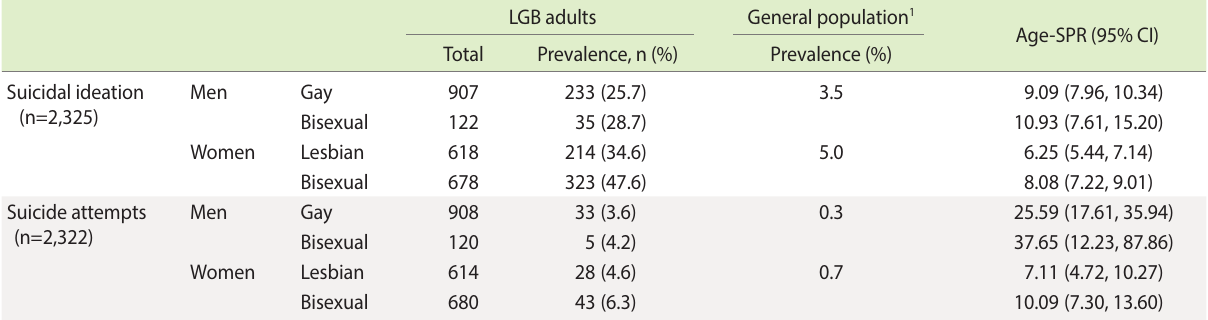
Table 5. SPR of suicidal ideation and suicide attempts over the past 12 months between LGB population (2016) and the general population (2013-2015) 1 in